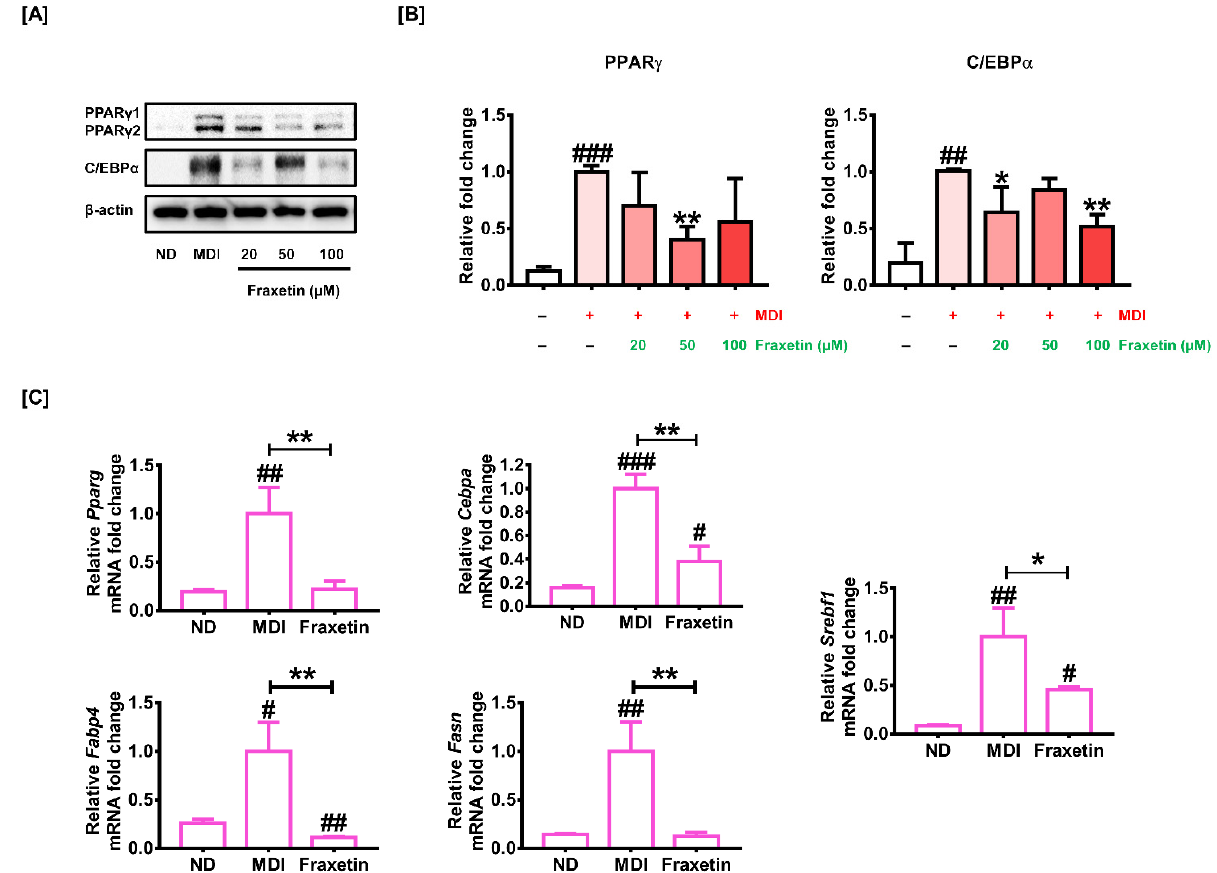
Figure 2. Effect of fraxetin on the expression levels of adipogenesis-related proteins and genes in 3T3-L1 cells. ( A , B ) Protein expression levels of PPAR γ and C/EBP α were assessed with Western blot analysis. The 3T3-L1 cells were incubated with or without fraxetin (20, 50, and 100 µ M) for differentiation. Then, the cells were lysed, and a Western blot was performed. The protein levels of PPAR γ and C/EBP α were normalized with β -actin. The different colors in bar graph represent the different concentration of fraxetin. ( C ) The transcriptional expressions of Pparg, Cebpa, Fabp4, Fasn, and Srebf1 genes were determined by RT-qPCR. GAPDH was used for the normalization of each gene expression. All experiments were performed at least three times. The asterisk symbol represents significant differences between the differentiated group and others (* p < 0.05, ** p < 0.01). The crosshatch mark represents significant differences between the nondifferentiated group and others (# p < 0.05, ## p < 0.01, ### p < 0.001), as verified using unpaired t-tests or one-way analysis of variance (ANOVA), followed by Dunnett’s post hoc